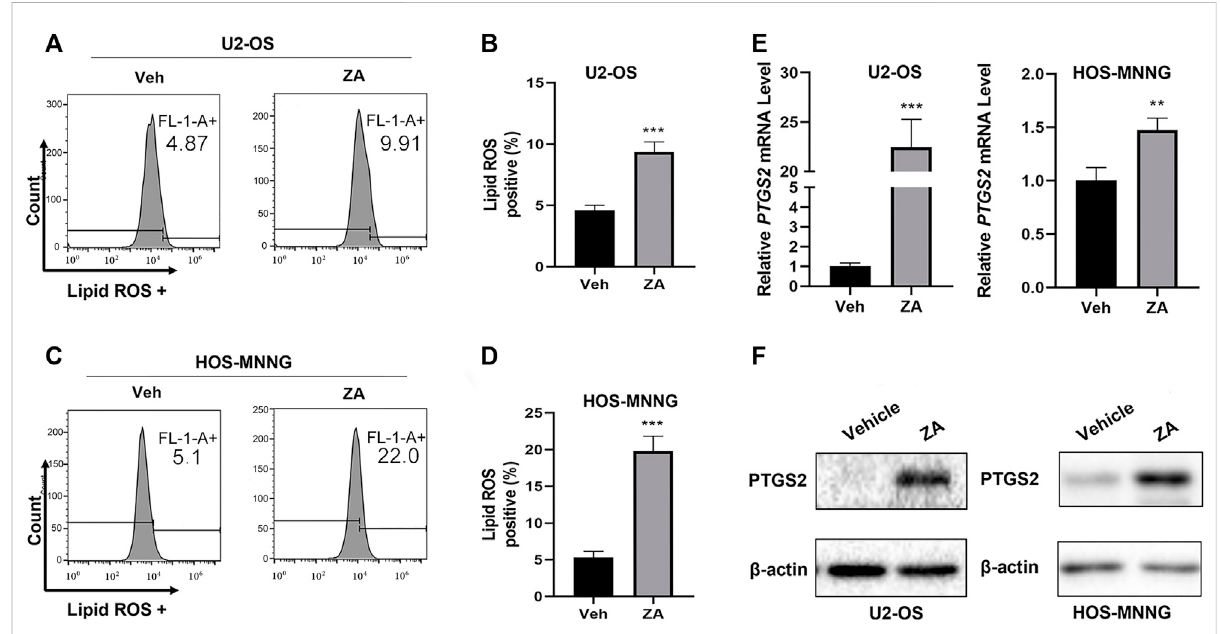
FIGURE 2 Zoledronicacidinducesferroptosisinosteosarcomacells. (A – D) Zoledronicacid(ZA)increaseslipidperoxidelevelsinosteosarcomacells. U2- OS (A,B) and HOS-MNNG (C,D) cells were treated with 20 μ M ZA for 24 h and incubated with BODIPY 581/591C11 (5 μ M) dye for 30 min. Flow cytometry was used to detect Lipid ROS levels. (B,D) Quantitation of the fl ow cytometry plots in triplicates for (A) and (C) are shown. ZA treatment enhances the mRNA (E) and protein (F) levels of PTGS2. mRNA and protein were extracted from ZA (20 μ M) treated (24 h) cells, respectively. PTGS2 mRNA level was analyzed by qPCR, and PTGS2 protein level was examined by western blot. The means ± SEM are indicated, n = 3. * p < 0.05, ** p < 0.01, *** p <